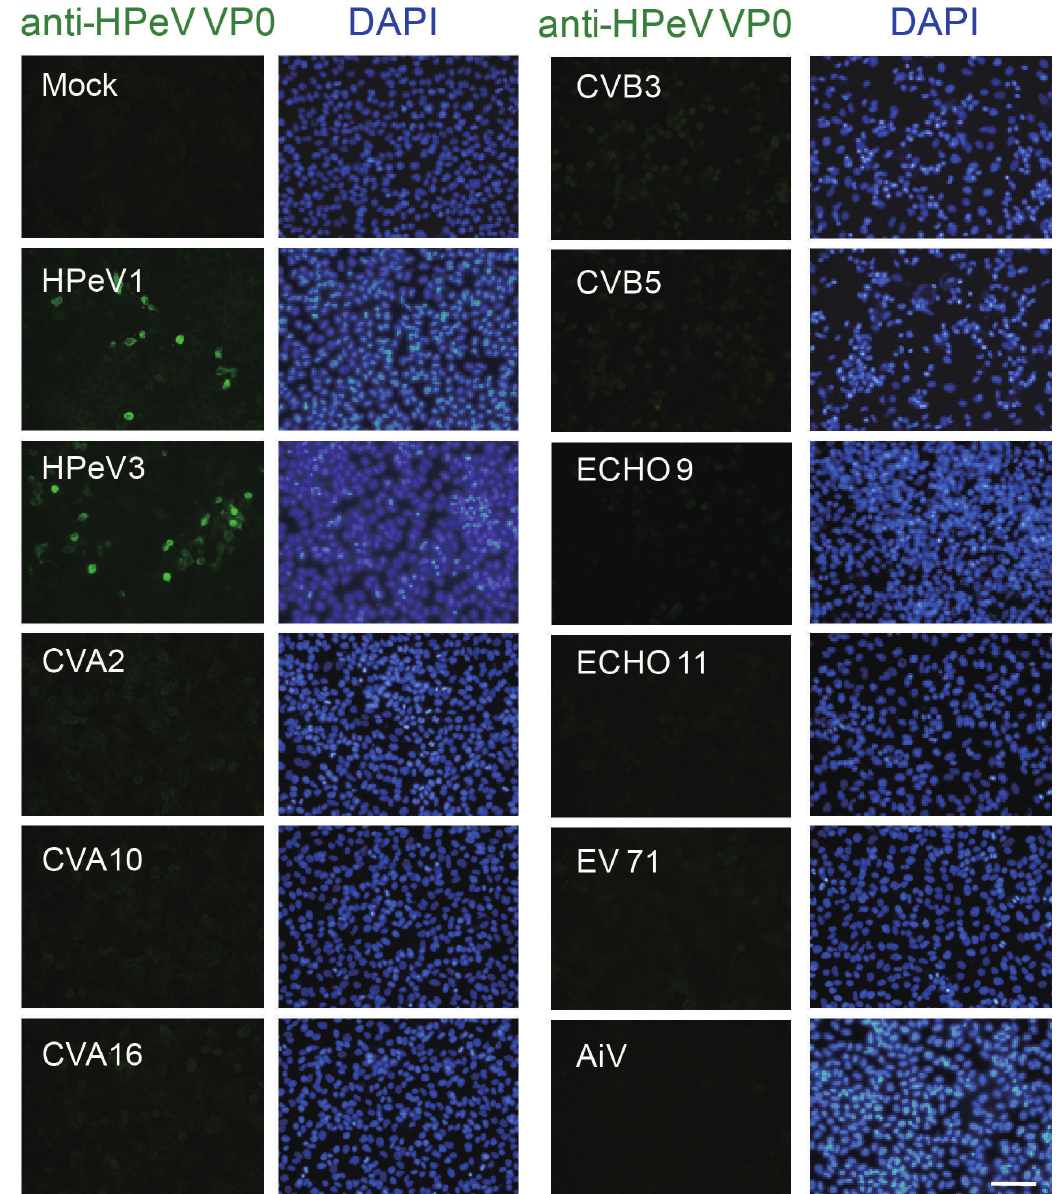
Figure 2. Specificity of anti-HPeV VP0 antibody. Immunofluorescence assay (IFA) was conducted in A549 cells (1 × 10 5 ) infected with HPeV1, HPeV3, echovirus 9 (ECHO 9), ECHO 11, enterovirus 71 (EV71), coxsackievirus A2 (CVA2), CVA10 and CVA16, coxsackievirus B3 (CVB3) and CVB5, Aichi virus (AiV) and mock control for 24 h. Green fluorescence indicates viral-infected cells identified by anti-HPeV VP0 antibody. The DAPI staining indicated the nuclear location, scale bar: 100 µ